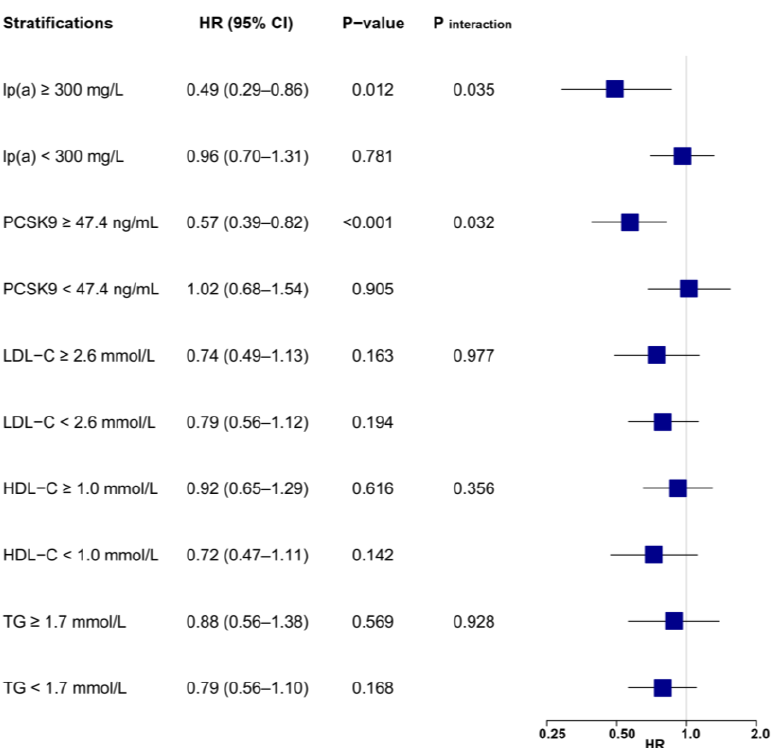
Figure 3. Associations between LL-37 and MACEs according to levels of lp(a) ( A ) and PCSK9 ( B ). MACEs = major adverse cardiovascular events; lp(a) = lipoprotein(a); PCSK9 = proprotein convertase subtilisin/kexin type 9; ↓ = low; ↑ = high.